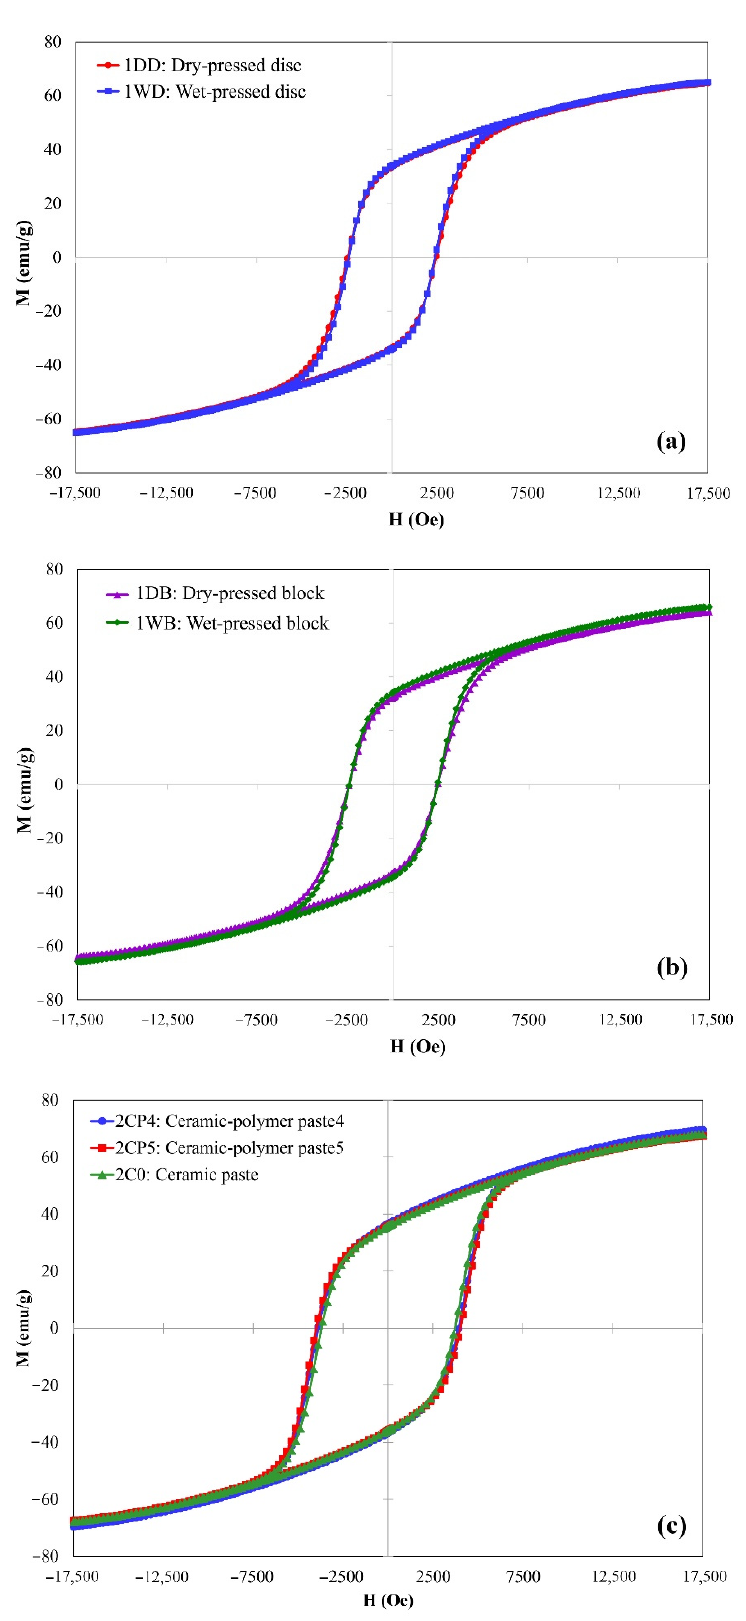
Figure 5. Hysteresis loops of ( a ) dry- and wet-pressed disc magnets; ( b ) dry- and wet-pressed bar magnets; ( c ) magnets from paste-injection molding.